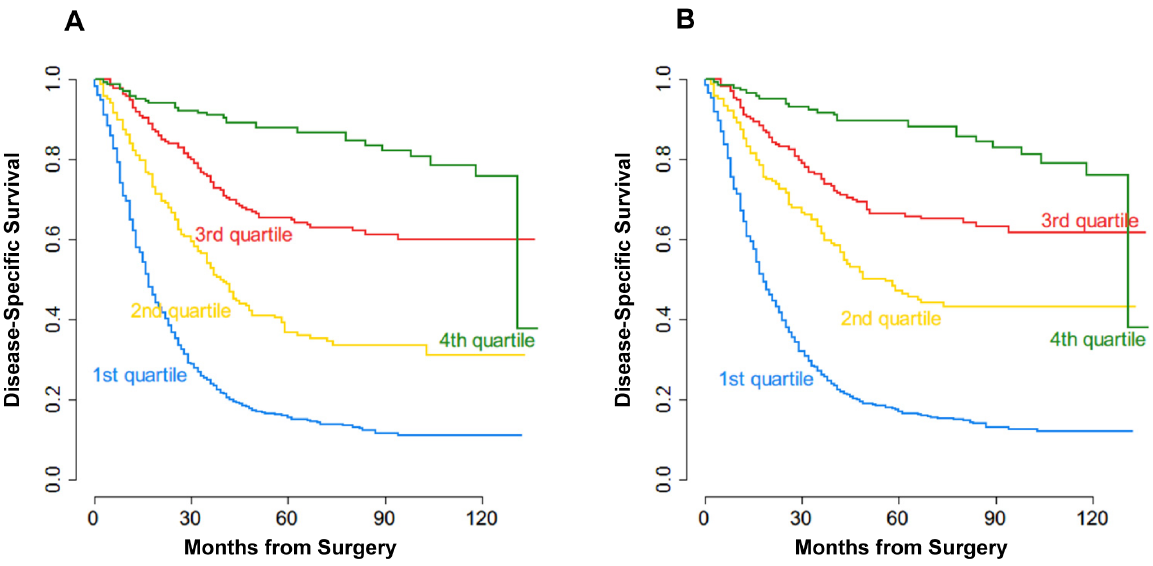
Figure 4. Kaplan-Meier curves for all patients stratified by quartiles of the MSKCC nomogram-predicted survival. Patients in the Chinese cohort were grouped into quartiles according to the nomogram-predicted survival (1st quartile, , 25%; 2nd quartile, 25–50%; 3rd quartile, 50–75%; 4th quartile, . 75%). (A) Five-year survival (B) Nine-year survival.